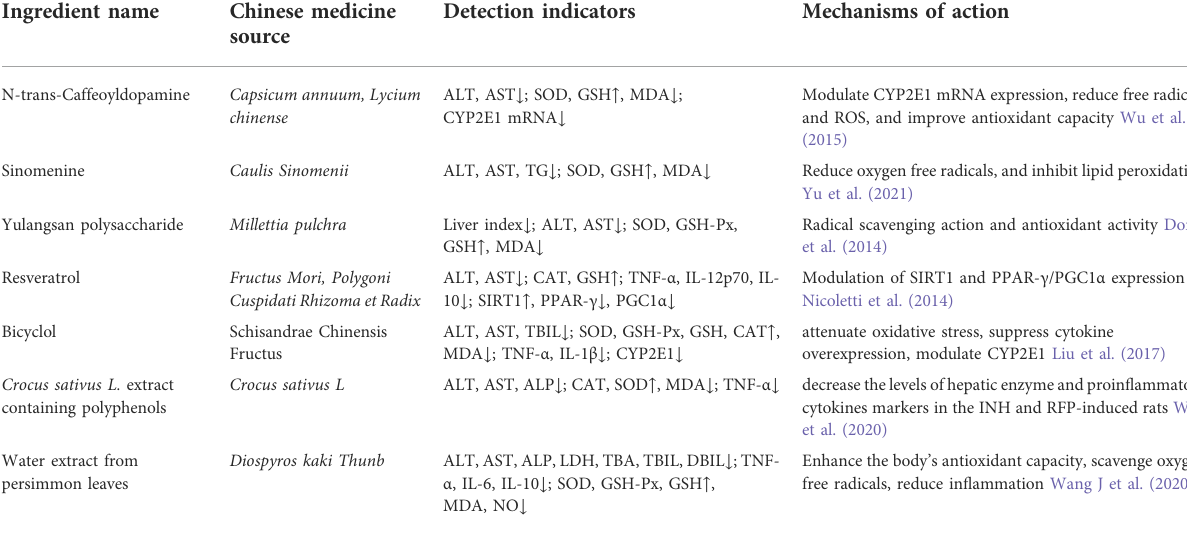
TABLE 4 Study on other natural medicinal ingredients against INH and RFP-induced liver